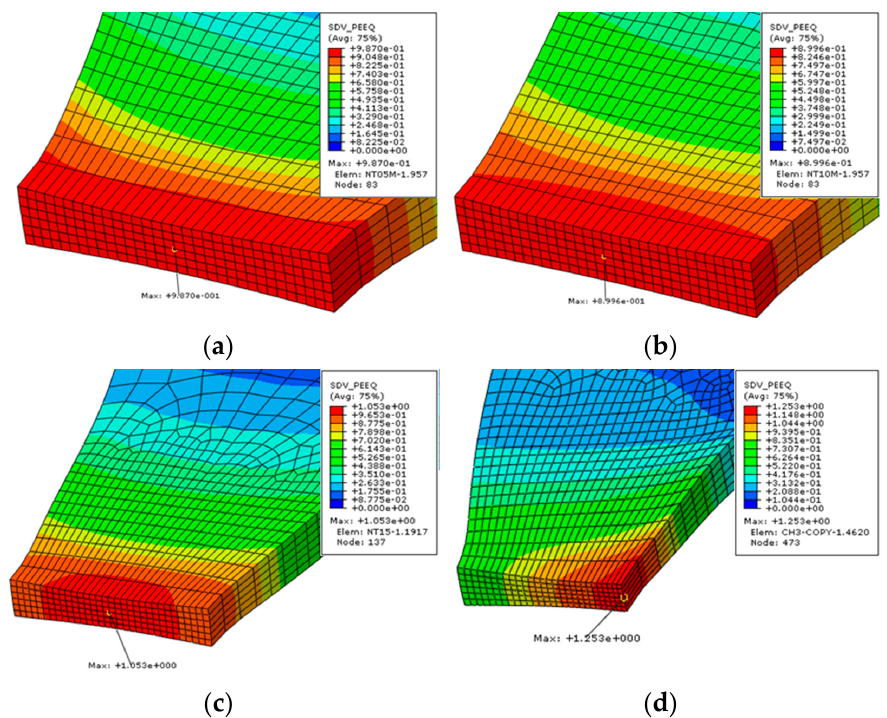
Figure 8. Equivalent plastic strain contour at damage initiation; ( a ) NT05 specimen, ( b ) NT10 specimen, ( c ) NT 15 specimen, and ( d ) CH03 specimen. In the NT specimen, when the stiffness drop occurred rapidly, the maximum equivalent plastic strain appeared at the center of the specimen. In the CH specimen, the maximum equivalent plastic strain was observed in the direction of the hole diameter due to symmetric structure of specimen. A decrease in thickness was observed in the numerical analysis model of all specimens.